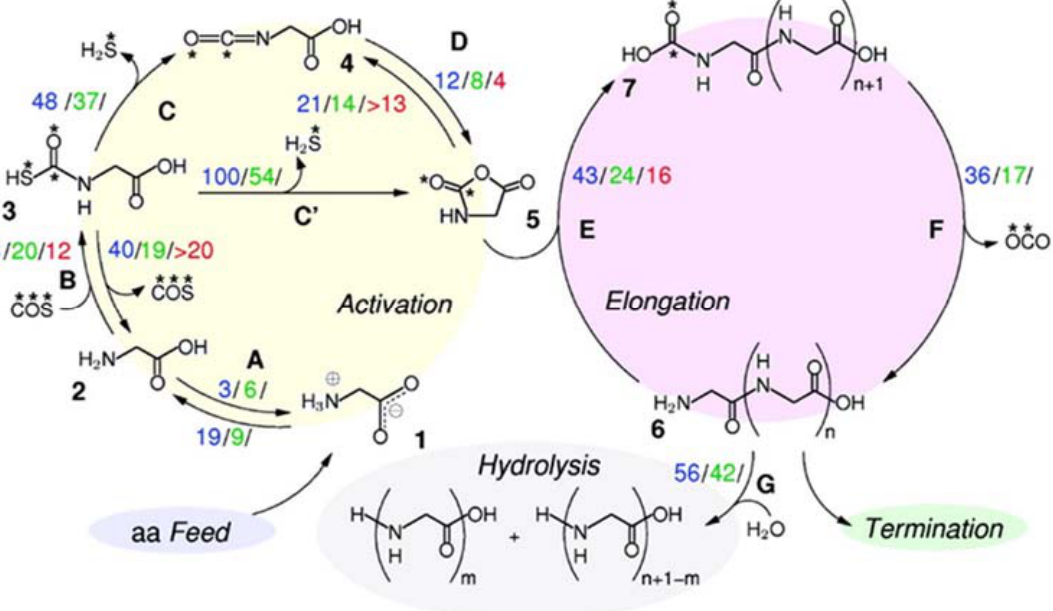
Figure 10. Results obtained through metadynamics for the peptide bond formation between two Gly molecules activated by COS and occurring under extreme conditions (hot pressurized water) on the FeS 2 surface. Units are in k B T. Stars labels the atoms arising from COS. Reprinted with permission from J. Am. Chem. Soc. 2008, 130, 9, 2768–2770. Copyright 2018 American Chemical Society.